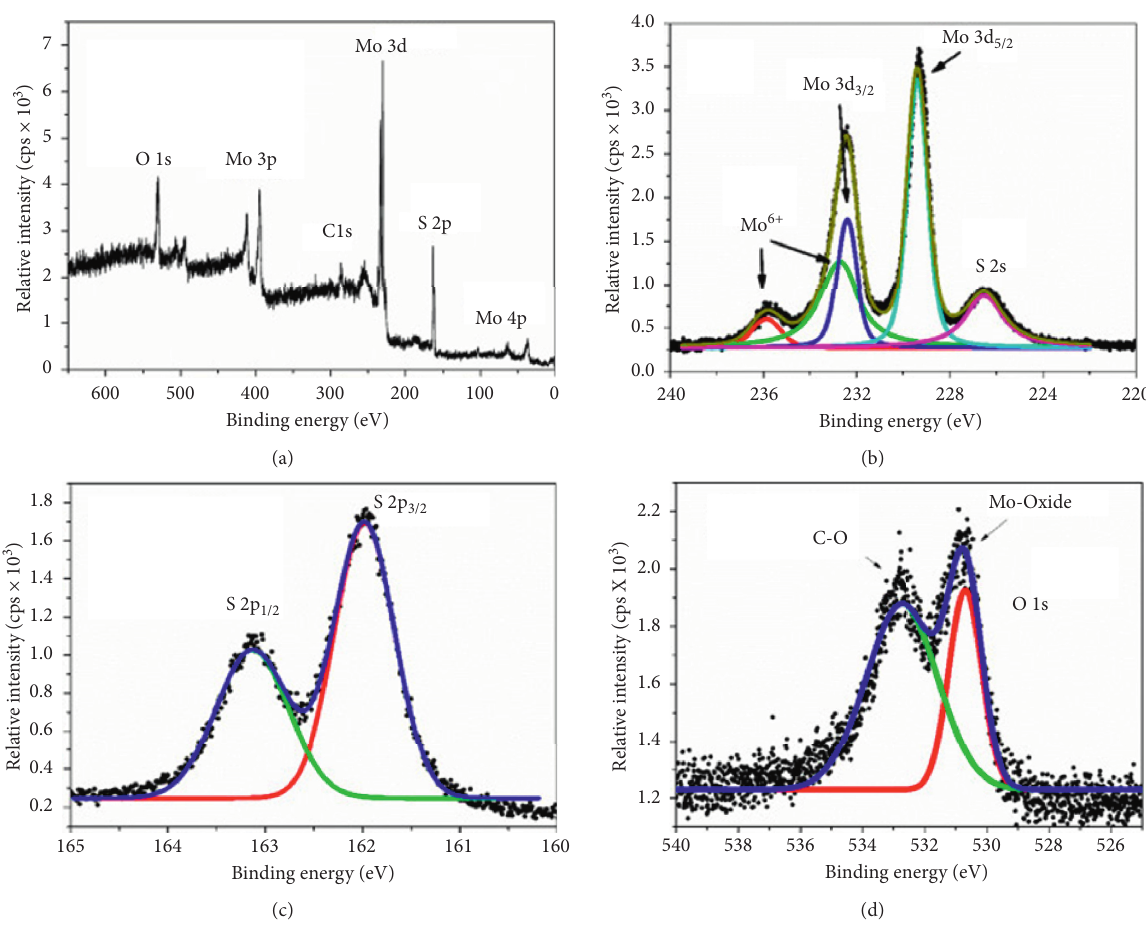
Figure 13: (a) XPS spectra of MoS 2 showing the doublets Mo 3d peak and S 2p peak and high resolution spectra of (b) Mo 3d peak doublet and (c) S 2p peak doublets. (d) High resolution spectrum of O 1s peak [115].